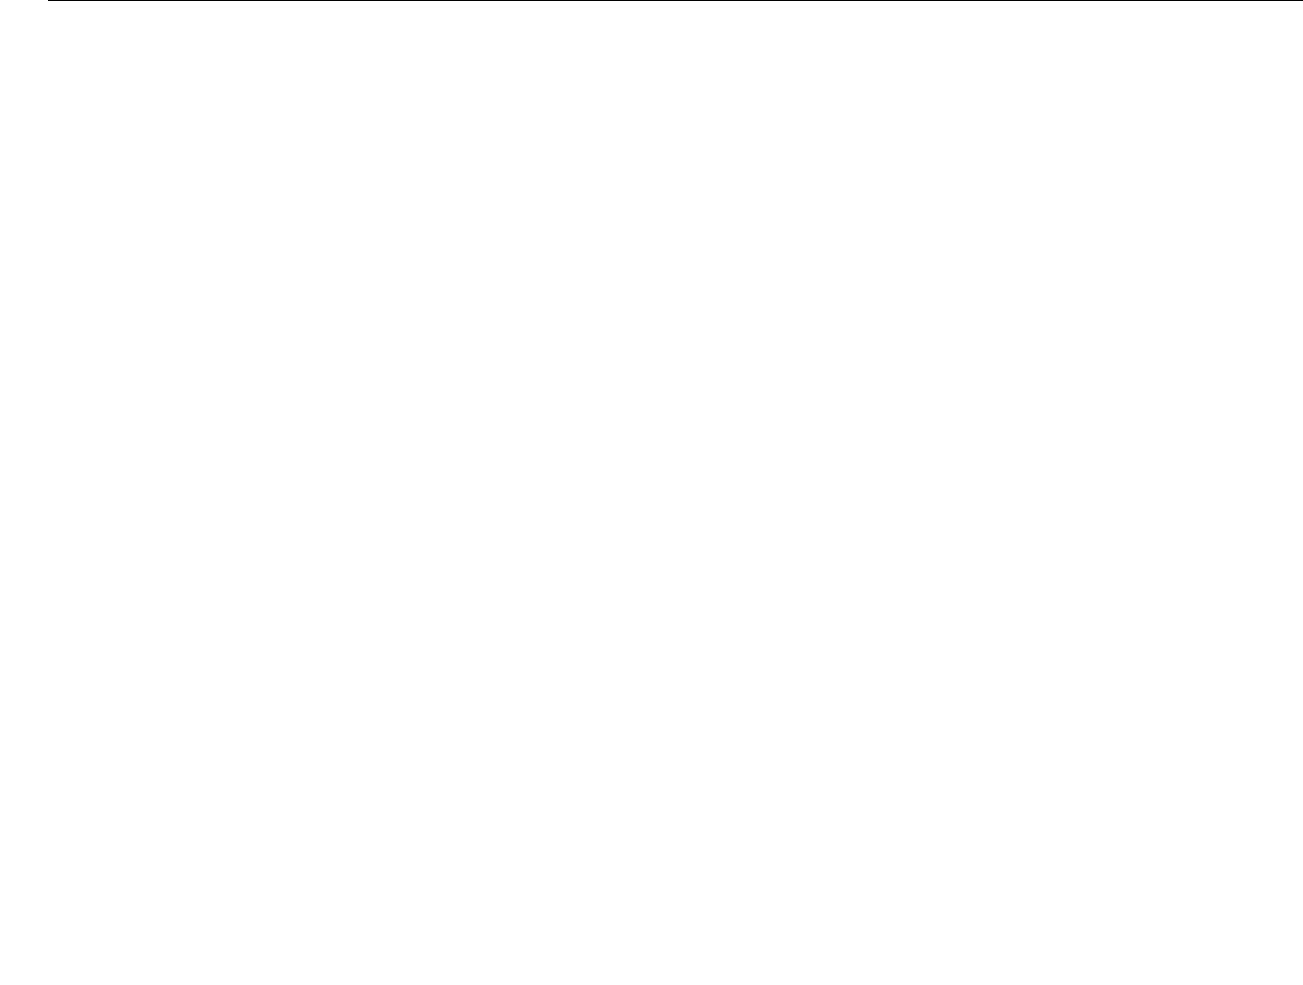
Frontiers in Pharmacology | www.frontiersin.org